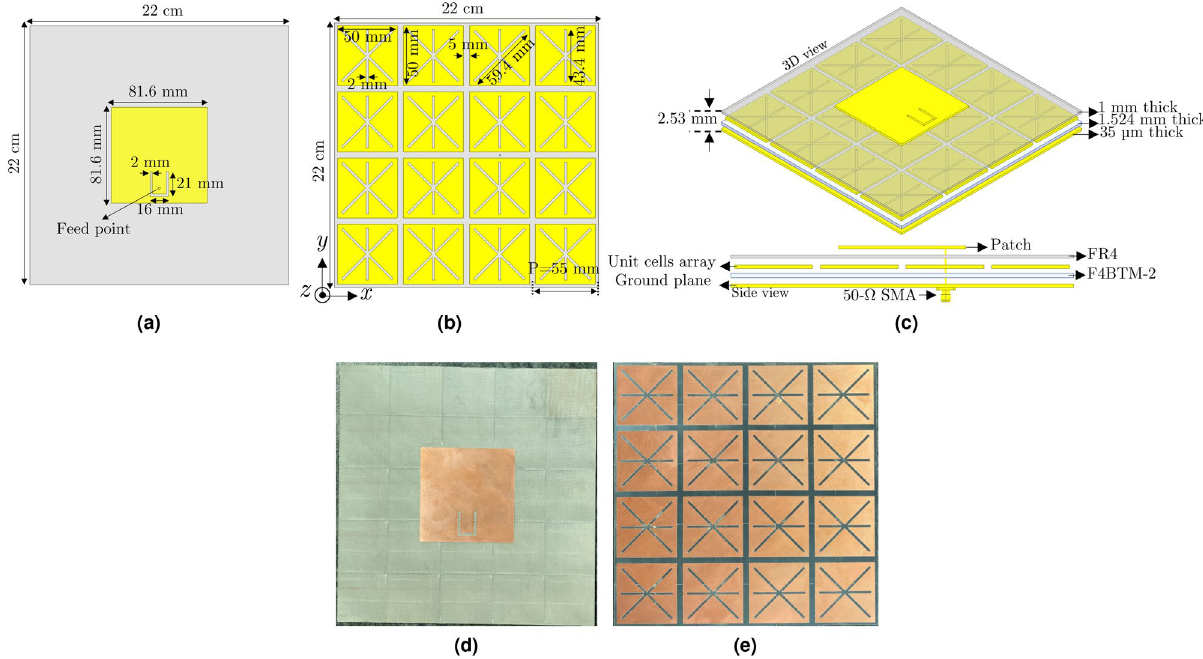
Figure 1. Geometry of the proposed metasurface patch antenna: ( a ) top-view of the patch; ( b ) top-view of the metasurface structure with 4